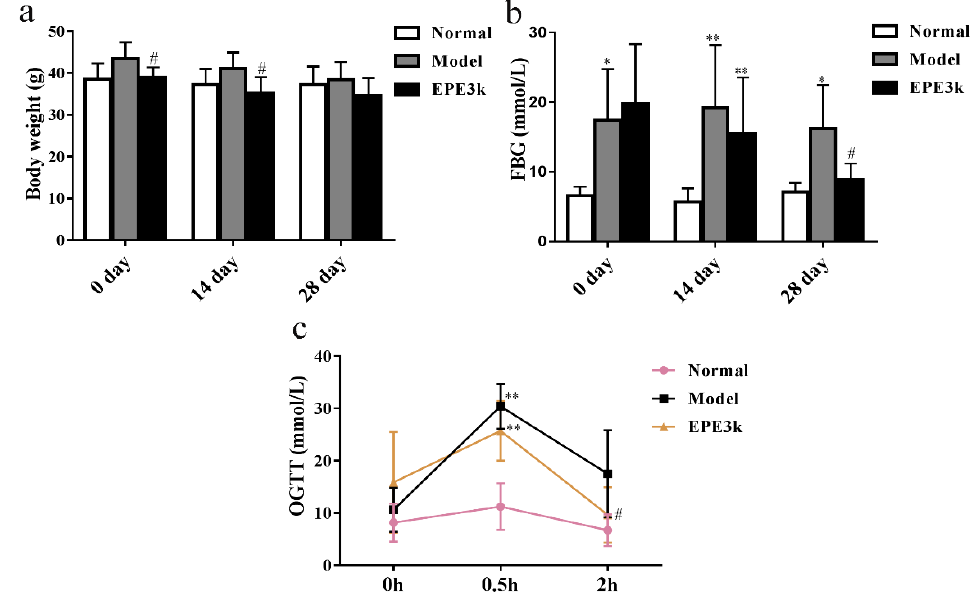
Figure 1. The variation on body weight ( a ), fasting blood glucose (FBG) ( b ), and oral glucose tolerance test (OGTT) ( c ) of type 2 diabetic mice after treated by EPE3k. * p < 0.05, ** p < 0.01: compared with normal group; # p < 0.05: compared with model group.